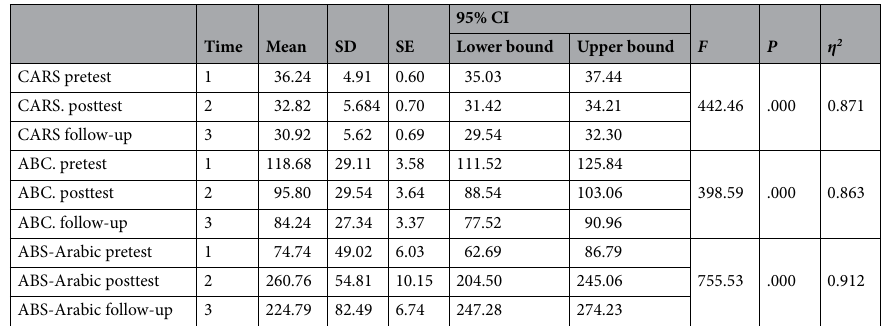
Table 1. Descriptive Statistics of Pre-. Post. and Follow-up Tests (n = 66). ABC autism behavior checklist, CARS childhood autism rating scale, ABS-Arabic adaptive behavioral scale-Arabic. N : total number of